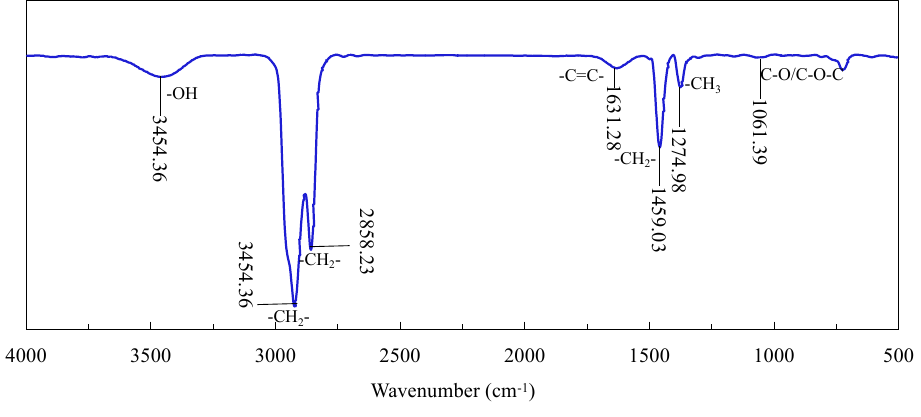
Figure 10. Infrared spectrum measurement results of diesel.